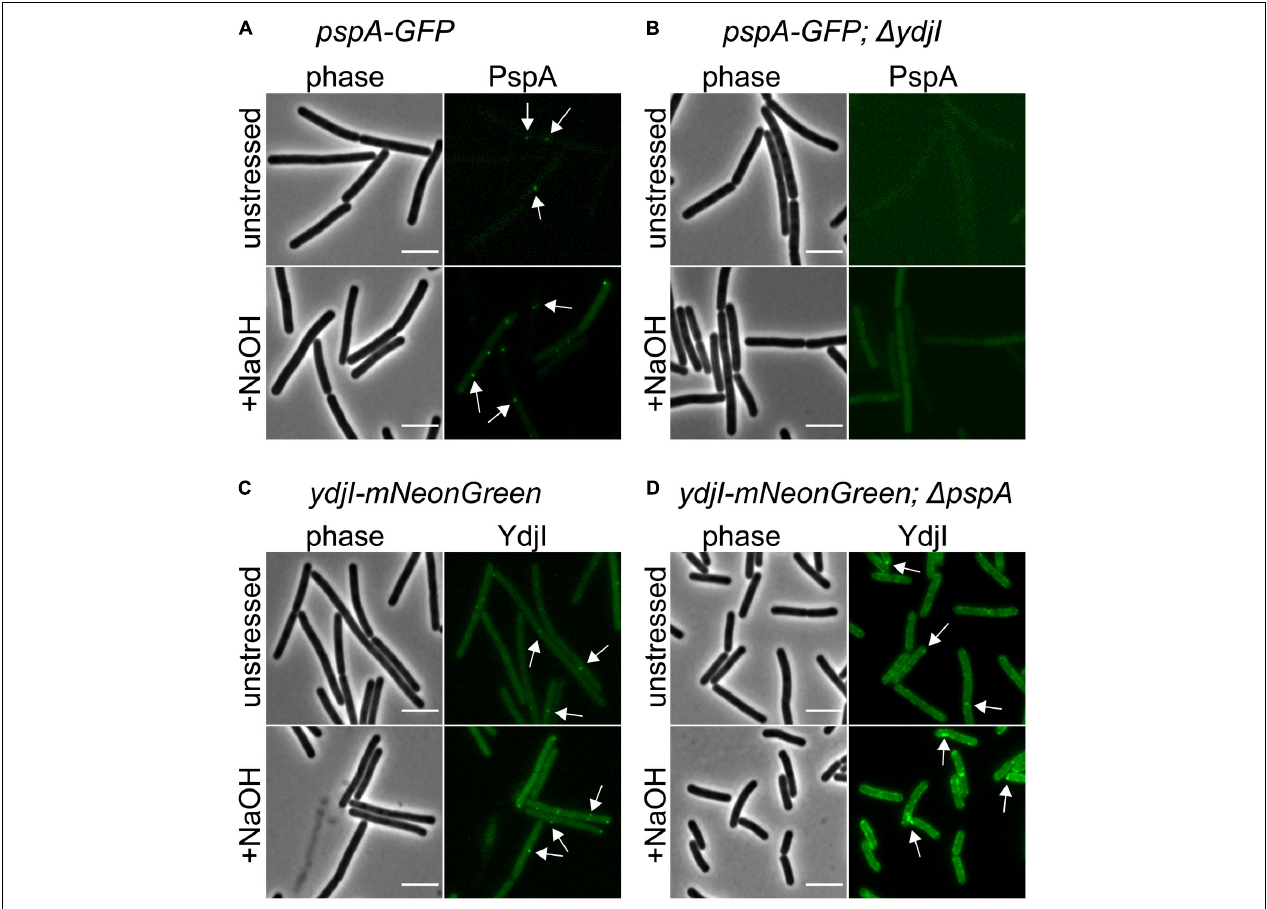
FIGURE 5 | YdjI is required for PspA membrane anchoring and complex formation. (A) PspA-GFP foci are shown in unstressed and alkali stress conditions. (B) Deletion of ydjI delocalize PspA and the cells show no PspA foci in both conditions. Scale bars: 4 µ m (C) ydji-mNeonGreen is shown under unstressed or stressed conditions (15 mM NaOH). (D) Deletion of pspA leads to YdjI overexpression. YdjI foci are still formed (arrows). Scale bars: 3 µ m.